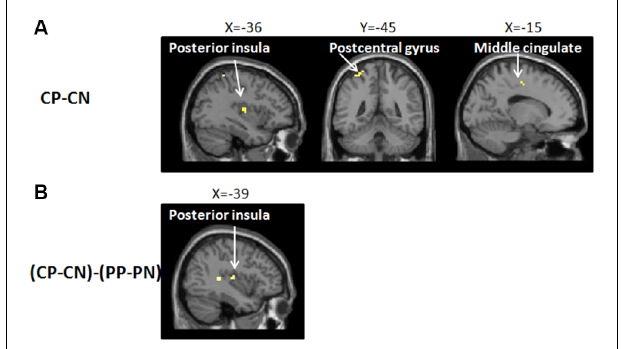
TABLE 1 | Activated regions in the contrast of (CP-CN), (CP-CN) − (PP-PN) and (PP+PN) − (CP+CN). Brain regions